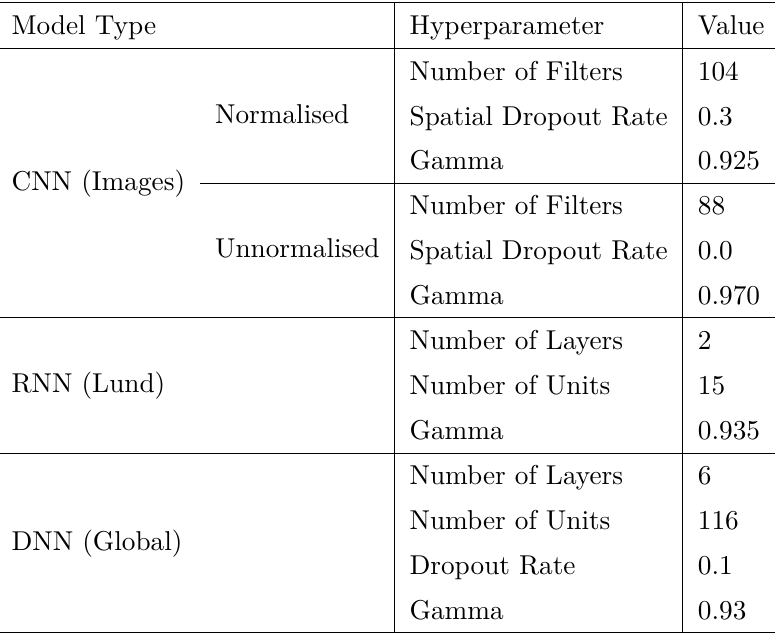
Table 2 . Best hyper-parameter configurations for each Deep Learning architecture